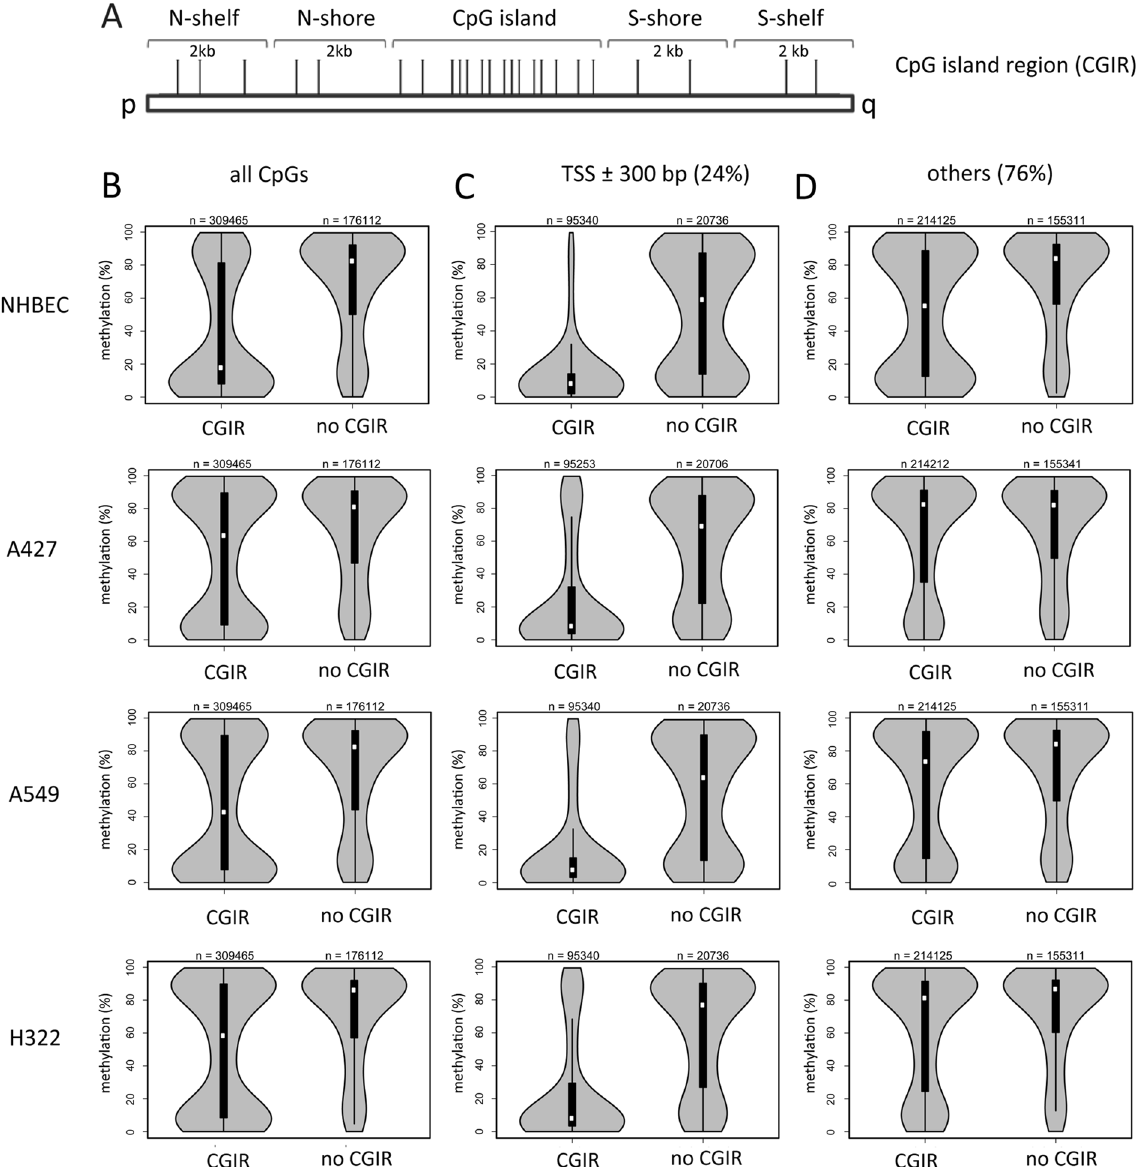
Figure 1. Increased methylation of CpG island-associated regions (CGIR) occurs in lung cancer cell lines. ( A ) GC and CpG rich genomic elements, termed CpG islands are flanked by 2 kb shore and 2 kb shelf regions. Depending on their orientation on the chromosome from the p- to q-arm these regions are denoted as N- or S-shores and shelves respectively. ( B ) Methylation levels of CpGs (n = 485,577) in CGIR (CpG island and flanking regions) and in no CGIR in normal human bronchial epithelial cells (NHBEC) and in three lung cancer cell lines (A427, A549 and H322) as quantified by 450 K bisulfite bead chip arrays and depicted in violin plots. ( C ) Methylation levels of transcription start site (TSS ± 300 bp flanking regions) associated CpGs (n = 116,076) were analyzed according to their location in CGI regions (CGIR) and no CGIR. ( D ) Methylation of CpGs outside of TSS ( ± 300 bp) were analyzed according to the position in CGIR and no